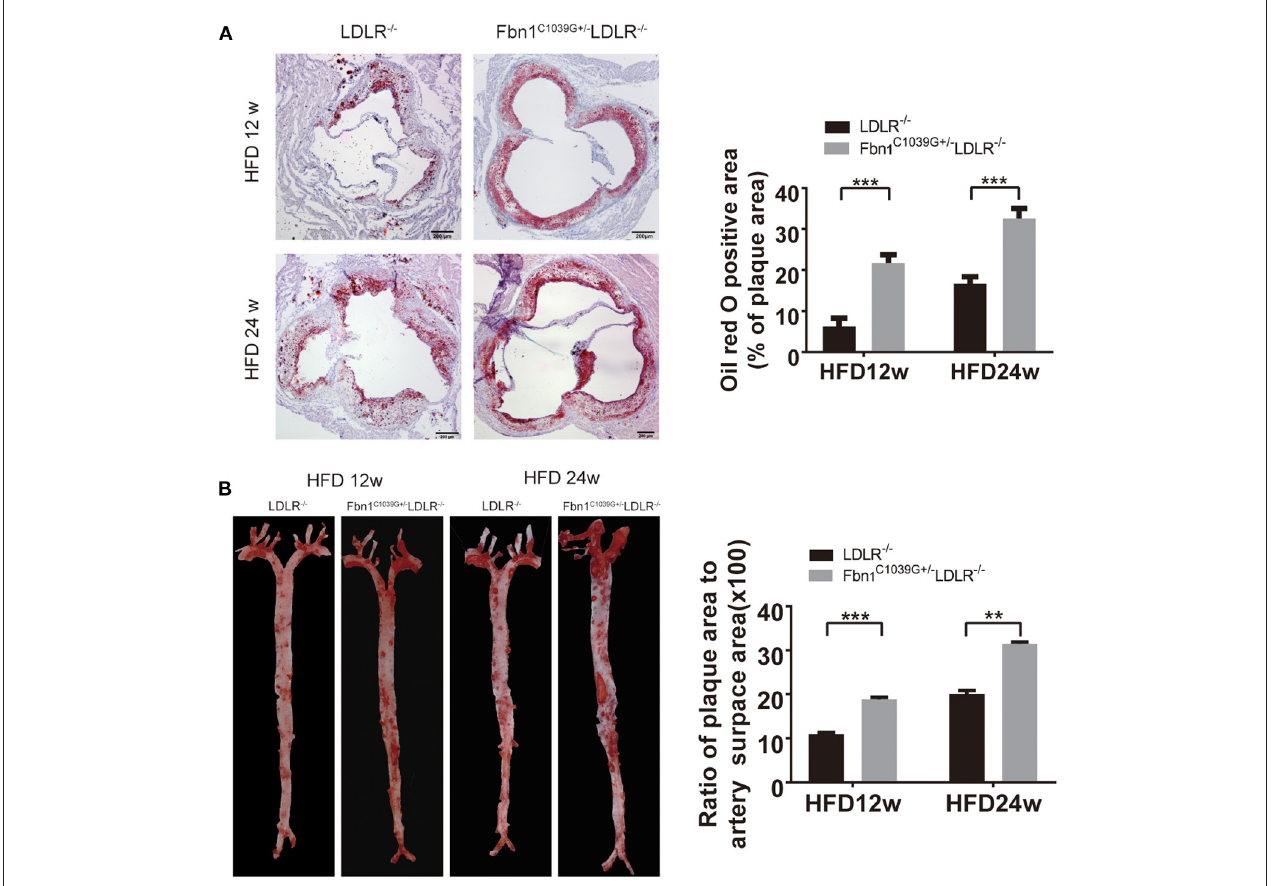
FIGURE 3 | Pathological staining of the aorta and aortic sinus of Fbn1 C1039G + / − LDLR − / − and LDLR − / − mice after 12 or 24 weeks on a HFD. (A) Oil red O staining of aortic sinus ( n = 5 per group). (B) En face oil red O staining ( n = 3 mice in each group). *** P < 0.001, ** P < 0.01. The results showed that the Fbn1 C1039G + / − LDLR − / − mice exhibited worsened